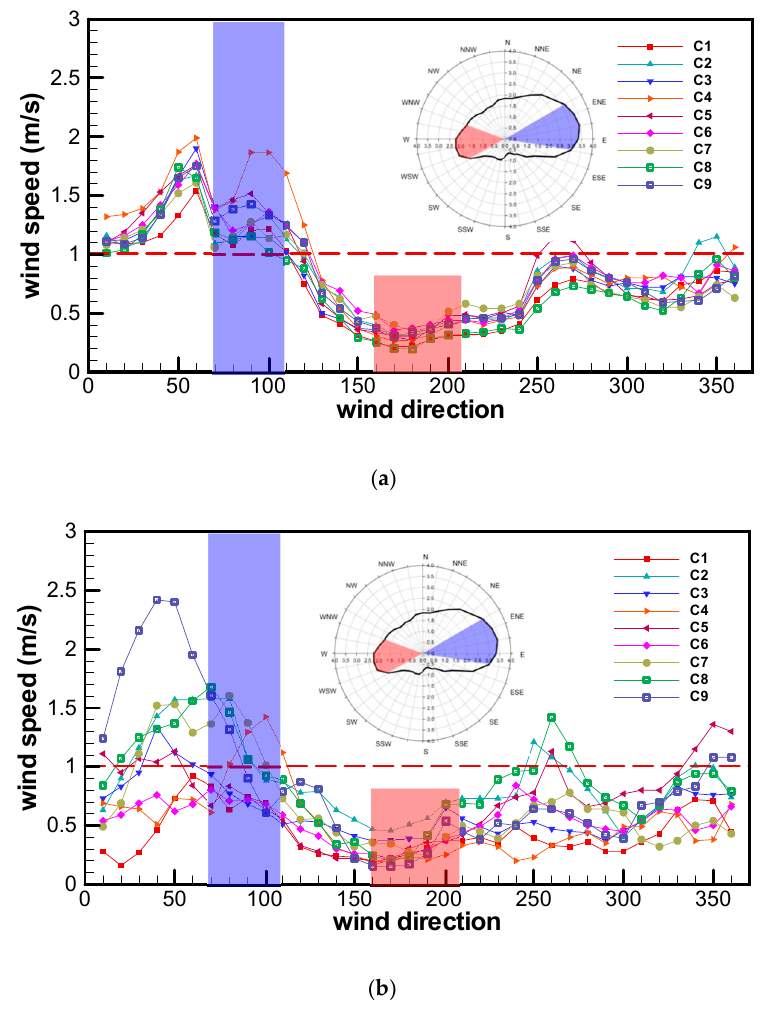
Figure 8. Mean pedestrian-level wind speeds in surrounding street canyons before and after urban renewal. ( a ) Before urban renewal; ( b ) after urban renewal.